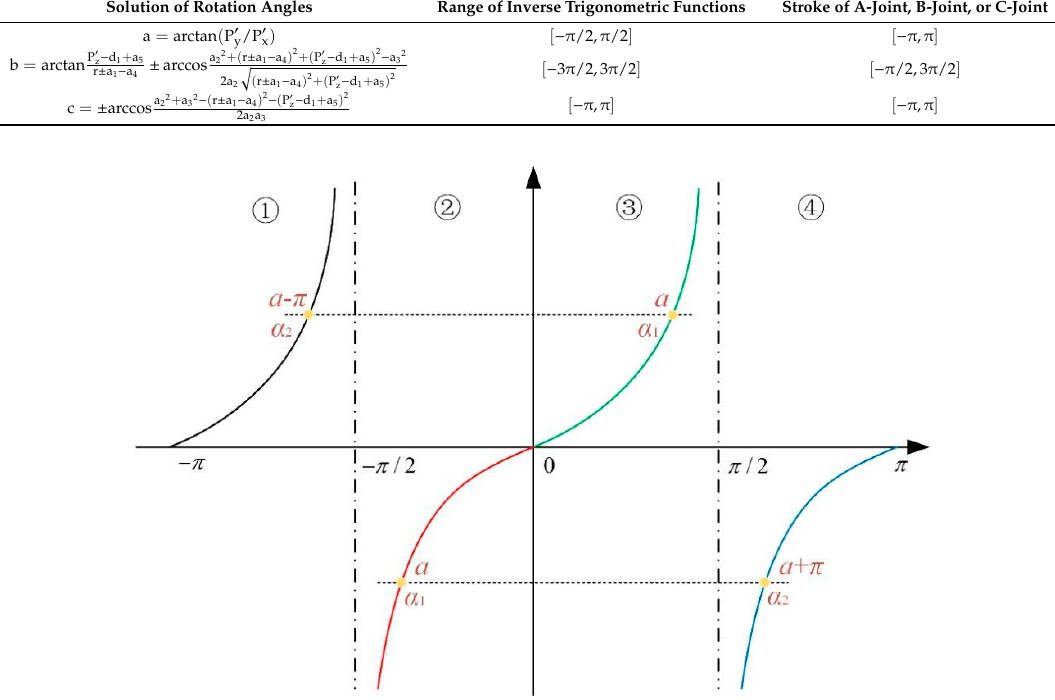
Figure 3. The curve of the tangent function when α is in the range of [ −π , π ]. Table 1. The range of inverse trigonometric functions and the stroke of rotation axes. Solution of Rotation Angles arctan(P / P )